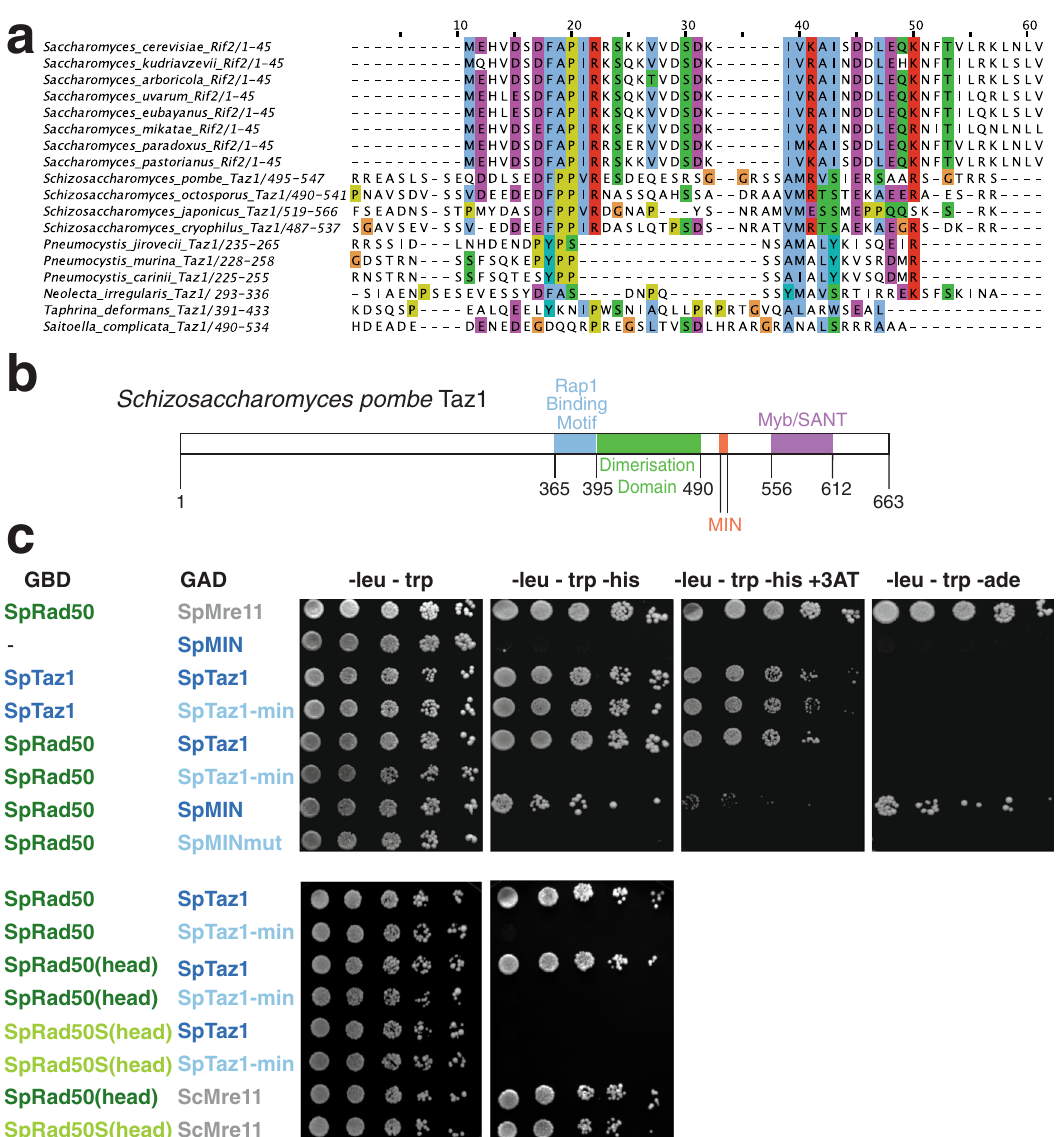
Fig. 7 A MIN motif in fi ssion yeast Taz1 binds the Rad50 N terminus. a Sequences of putative Taz1 proteins from the Taphrinomycotina were aligned using Clustal Omega with the N-terminal region of Rif2 from Saccharomyces species. b Diagram of the domain structure of Schizosaccharomyces pombe Taz1. Domains previously identi fi ed in SpTaz1 76 are indicated for the C-terminal half of the protein. The MIN motif is in orange. c Yeast two-hybrid assays of the S. pombe fusion proteins are indicated. Plates are minimal medium lacking the nutrients indicated on top (and one instance containing 3 mM 3- aminotriazole). Five-fold serial dilutions were spotted left to right and incubated for 3 – 4 days at 30 °C. Source data are provided as a Source Data fi